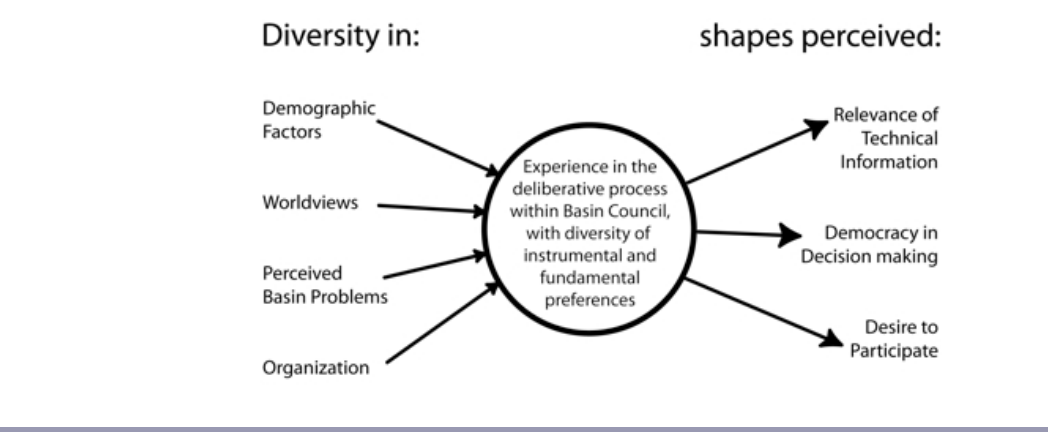
Fig. 1 . A subset of outcomes of the deliberative process in basin